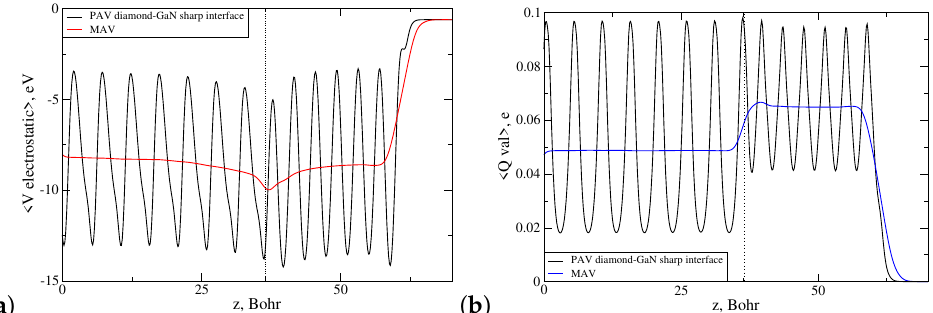
Figure 11. Laterally (PAV) and macroscopically (MAV) averaged profiles of the ( a ) electrostatic potential and ( b ) valence electron charge density of the N-C abrupt diamond–GaN interface type. A dotted line points to the average z-th position of the topmost N atoms.